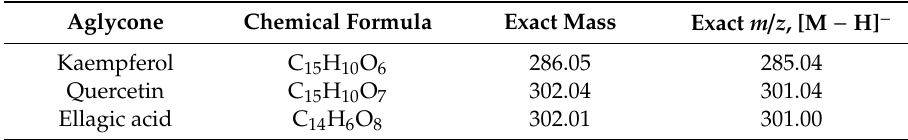
Table 1. Aglycones of tentatively identified phenolic compounds in ripe strawberry